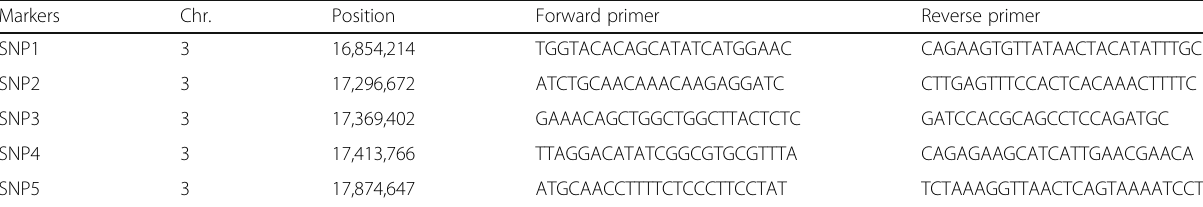
Table 2 Five SNP markers used to selection target chromosome segment Markers